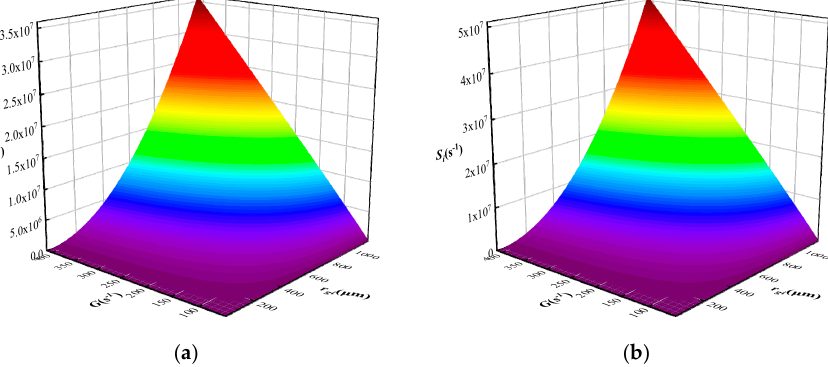
Figure 6. Breakage rate coefficient in PBM of ( a ) run 16; ( b ) run 20. The x-axis and y-axis represent the shear rate G and gyration radius r gi , respectively. The z-axis denotes the breakage rate coefficient S i . Moreover, f 1 , . . . , f 6 of the PBM of each experiment run is quite different from that of other runs, indicating that all of the six fitting parameters vary with flocculation